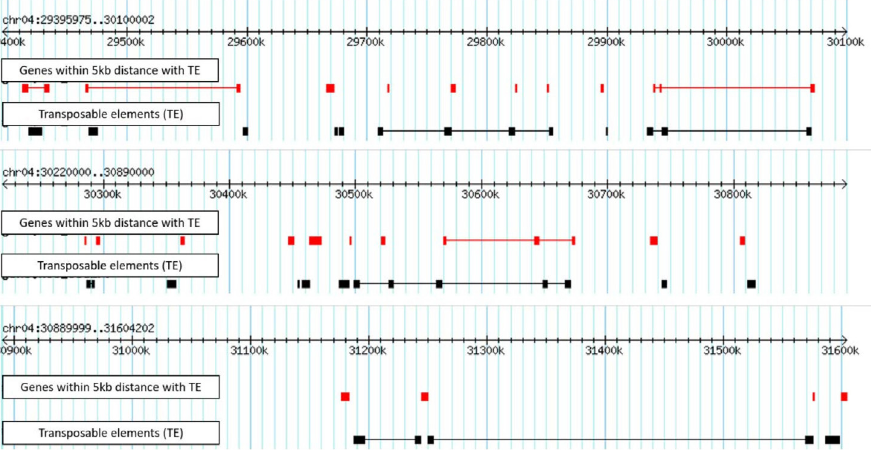
Fig. 1. Overview of TE distribution in qBFR4 (red box represent genes within 5kb distance with TE, black box represent TE, line between genes represent tandem repeats of the genes)